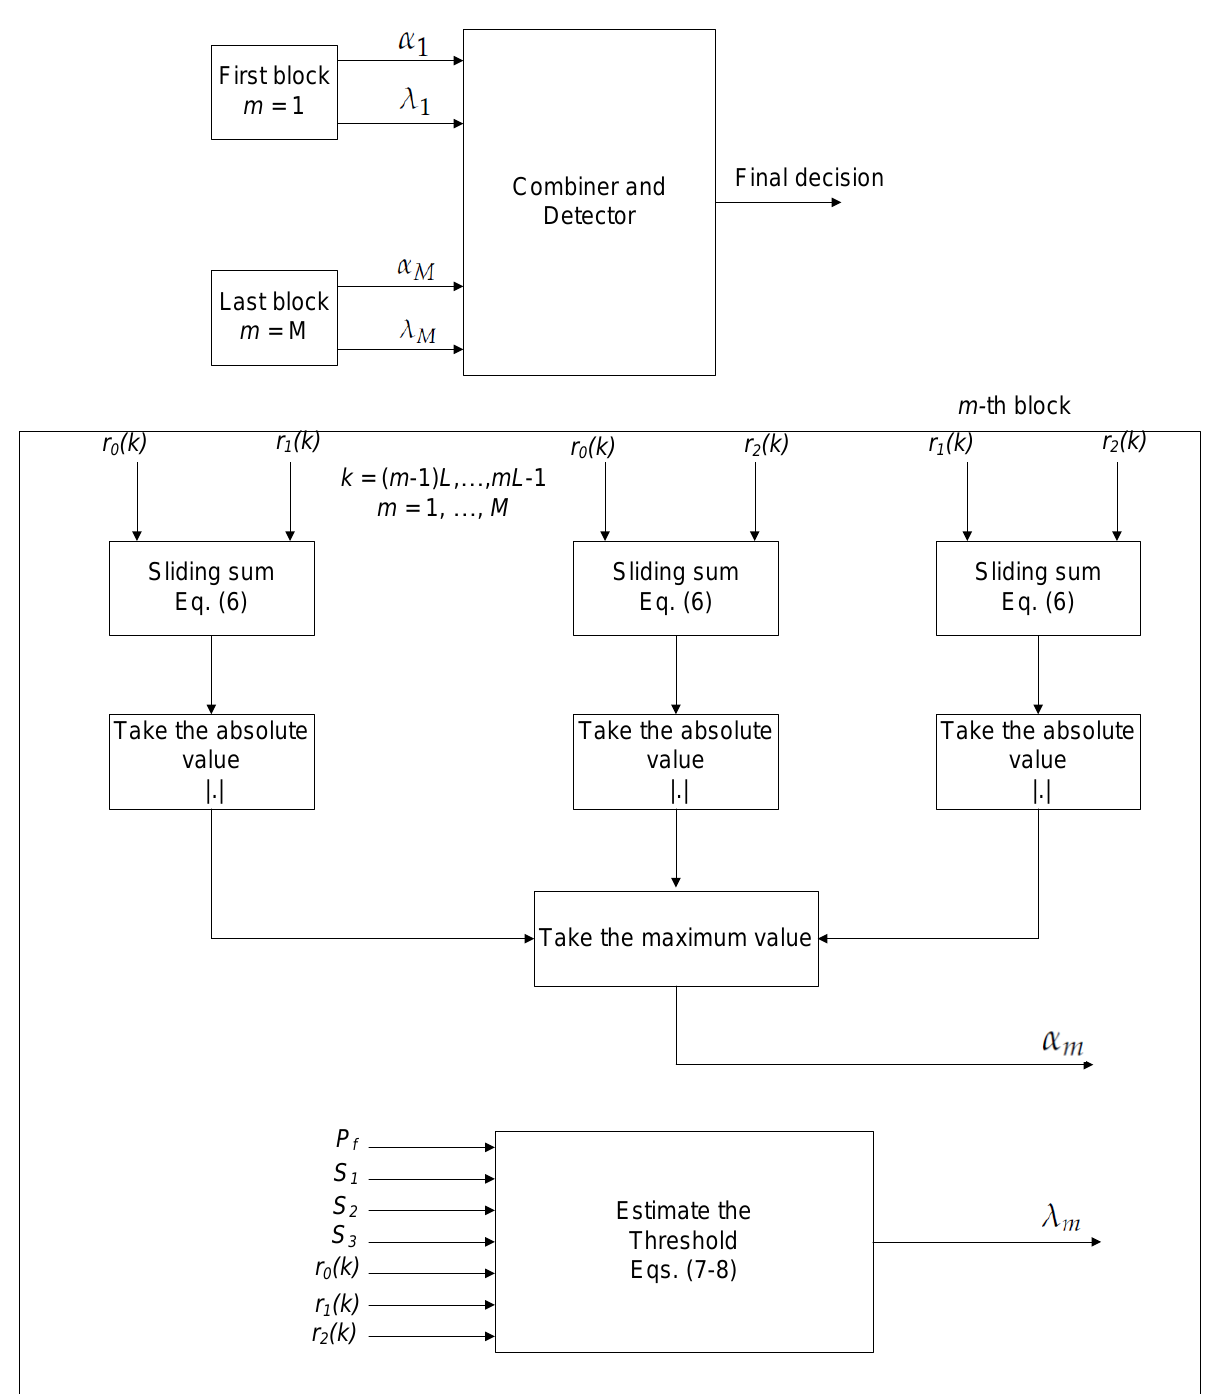
Figure 3. The conceptual block diagram of the proposed algorithm with three receive